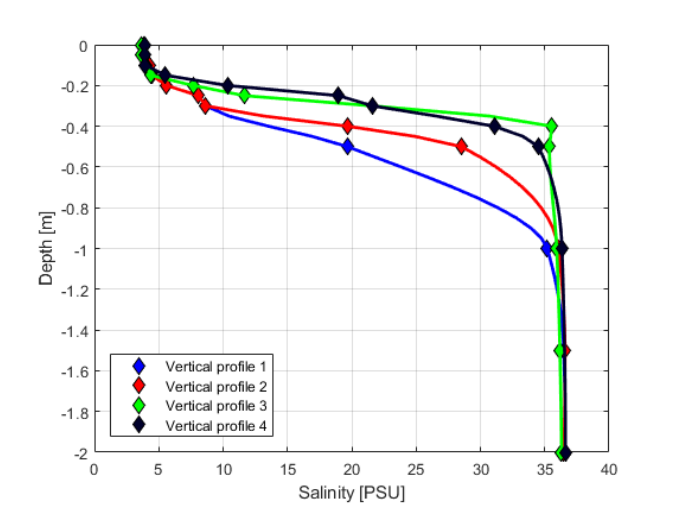
Figure 14. Vertical salinity profiles indicating the presence of the salt wedge stratification.